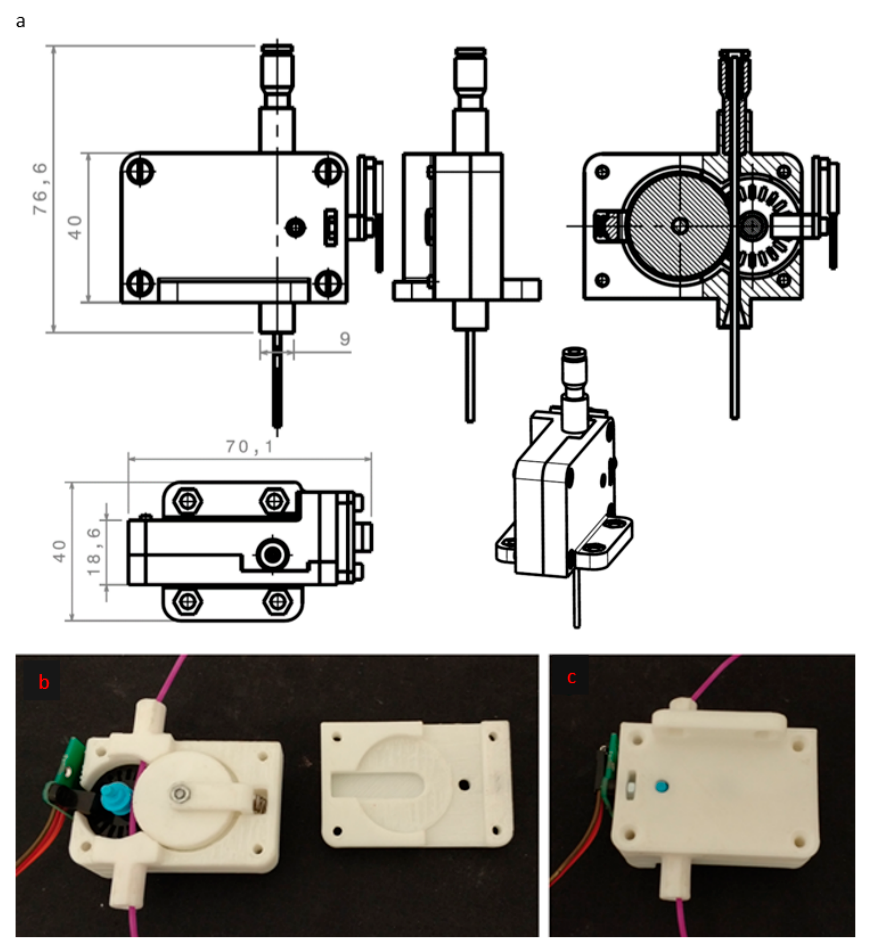
Figure 3. Real product: ( a ) Optimal design model; ( b ) and ( c ) Real product made with a 3D printer.